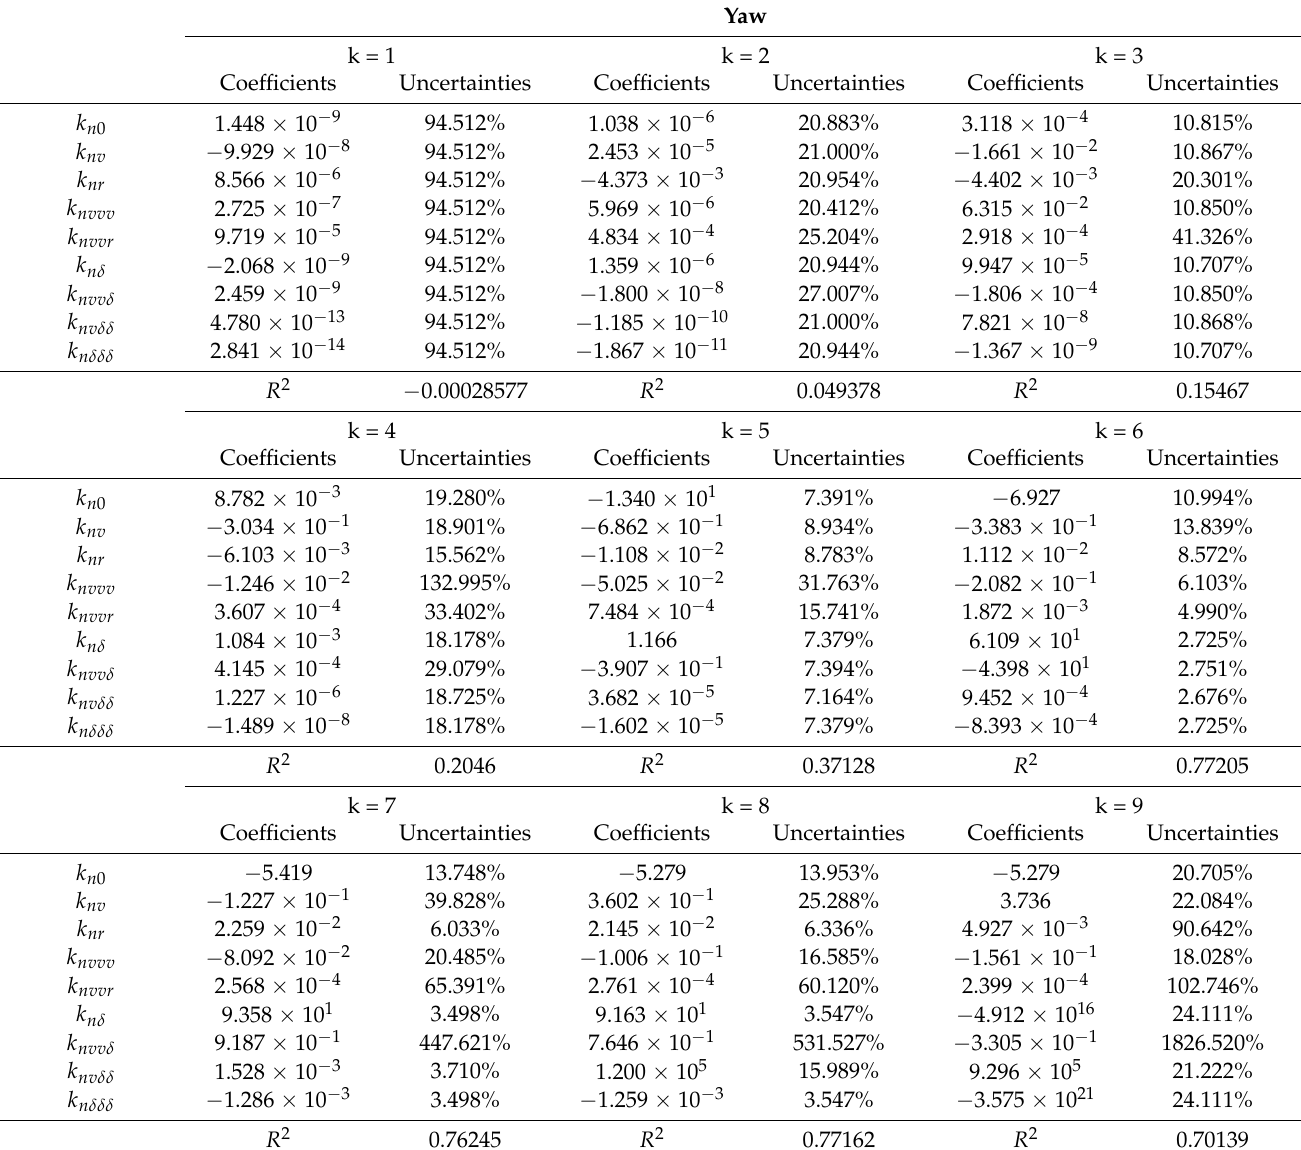
Table 7. Yaw adjustment coefficients and uncertainties for tests’ data from the 30 ◦ − 30 ◦ zigzag